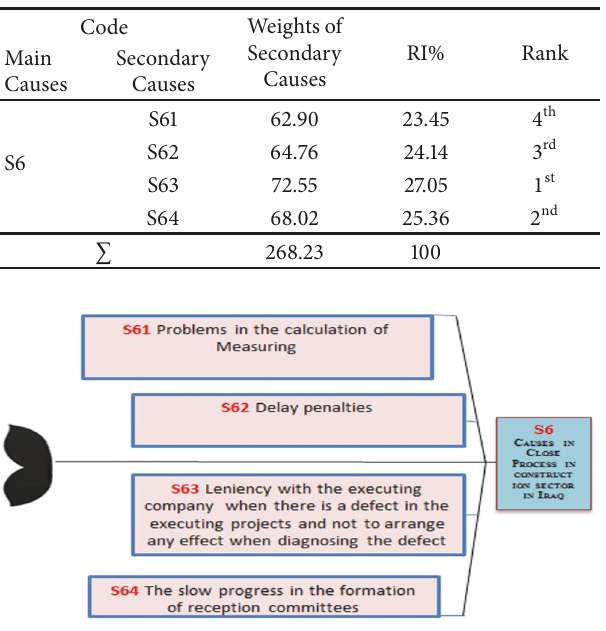
Figure 13: Fishbone diagram for project close management process group.